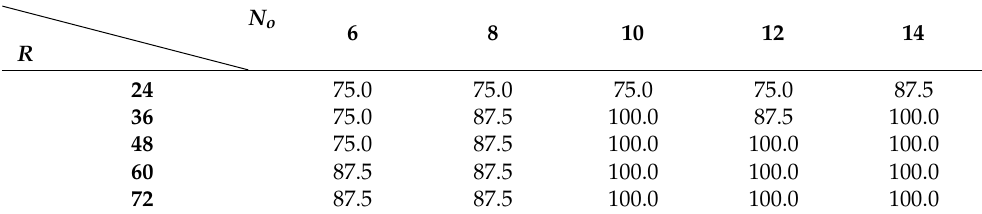
Table 1. SR with different parameter settings (%).